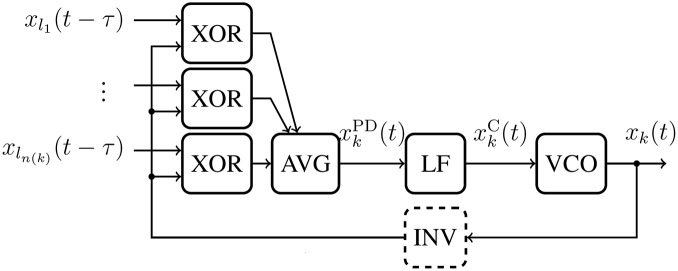
Signal flow of a DPLL with multiple delayed input signals.Each input signal xli (i = 1, …, n(k)) undergoes the XOR operation with the feedback signal individually. The resulting signals are averaged (AVG). © 2015 IEEE. Reprinted, with permission, from IEEE Proceedings: Synchronization of mutually coupled digital PLLs in massive MIMO systems.